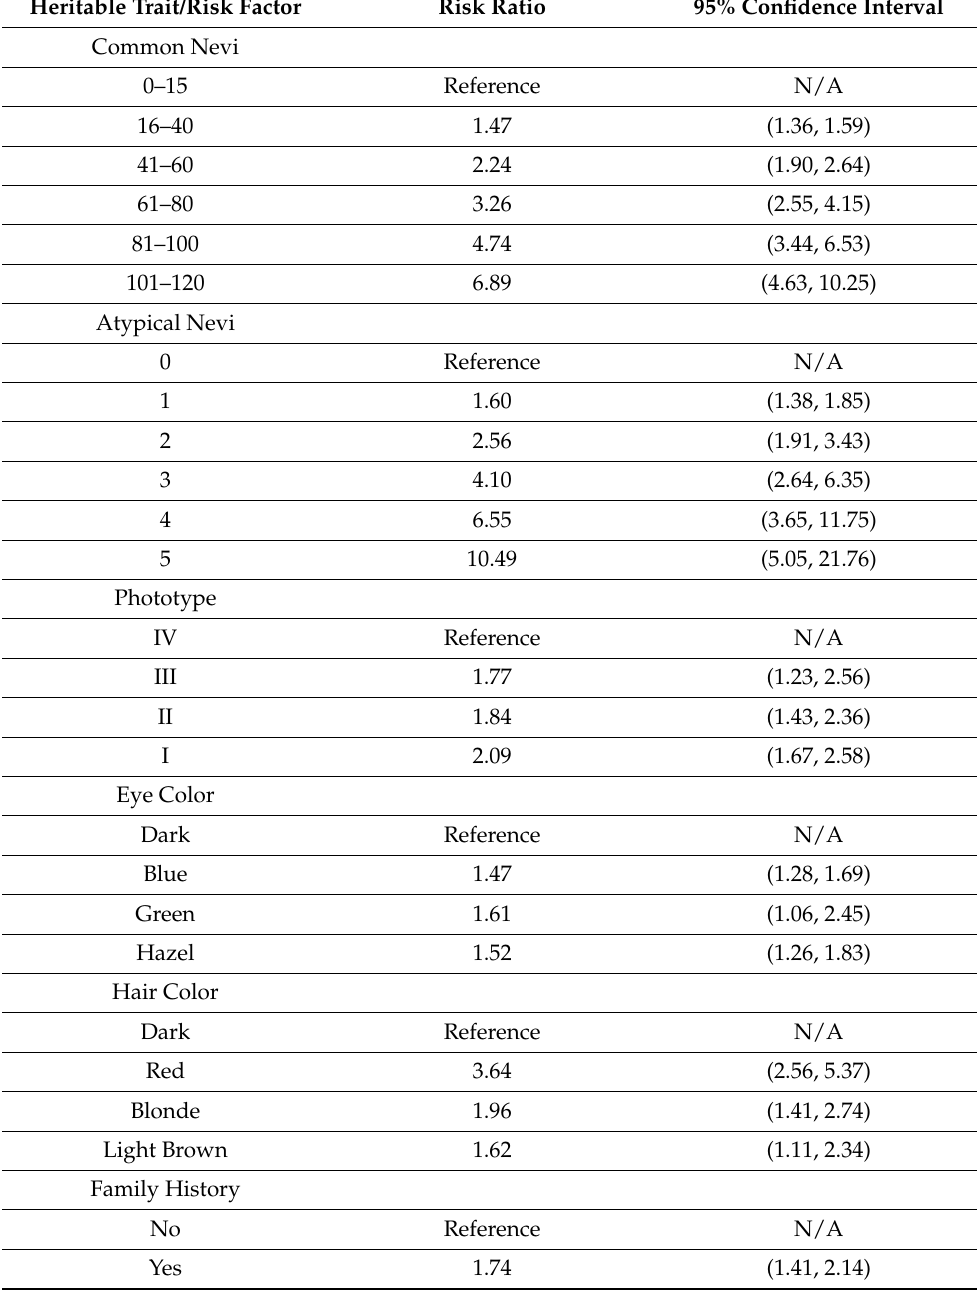
Table 1. Heritable and nonmodifiable risk factors and their associated risk ratios for melanoma